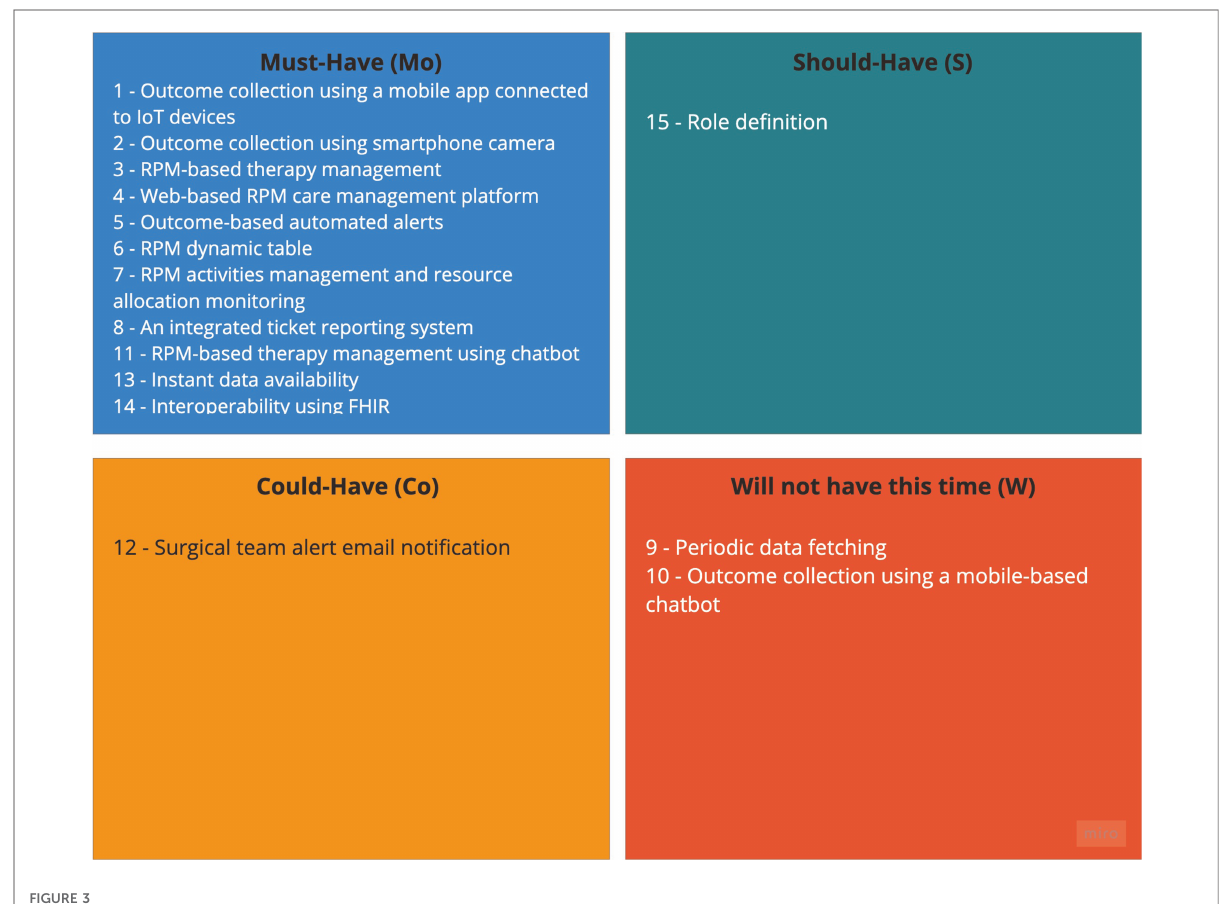
FIGURE 3 Diagram of the features of the three previously developed pilot initiatives. Each category is represented with a letter and a color: must-have - Mo (blue), should-have - S (green), could-have Co (yellow), and will not have this time - W